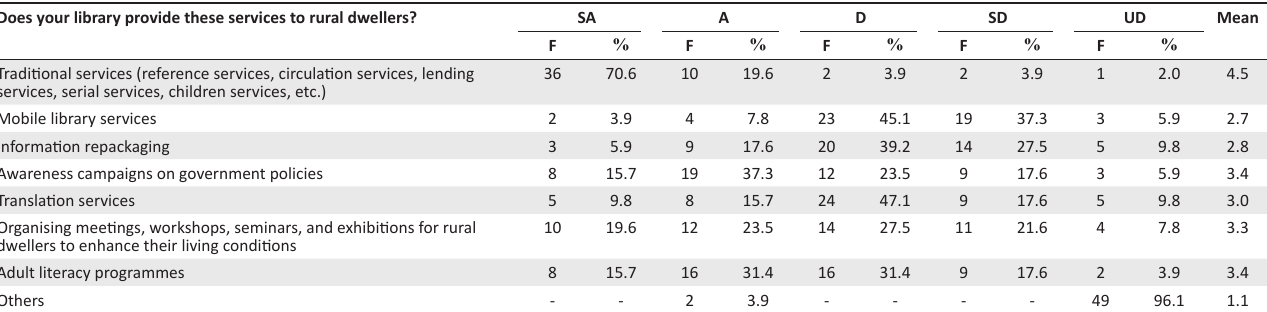
TABLE 14: Opinions of the heads of branch libraries on the forms of information services provided by public libraries to rural dwellers ( N = 51). Does your library provide these services to rural